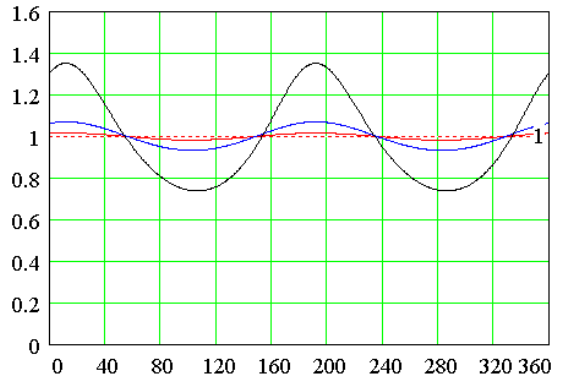
Figure 10. The plots of the transmission ratio ω 3 / ω 1 for different values of the angle between axes: π /36 (red); π /18 (blue); and π /9 (black).